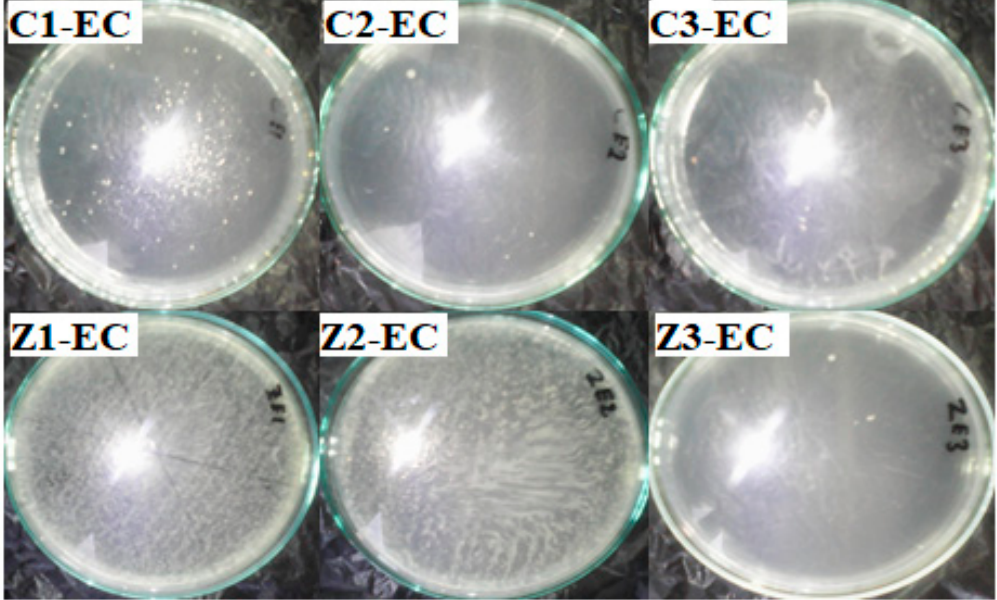
Figure 22. Antibacteria activity of clay / CuO / Ag and clay / ZnO / Ag against E. coli. C1-EC, C2-EC, C3-EC correspondingly relates to clay / CuO / Ag-1, clay / CuO / Ag-2 and clay / CuO / Ag-3 against E. coli. Z1-EC, Z2-EC, Z3-EC correspondingly relates to clay / ZnO / Ag-1, clay / ZnO / Ag-2 and clay / ZnO / Ag-3 against E. coli .